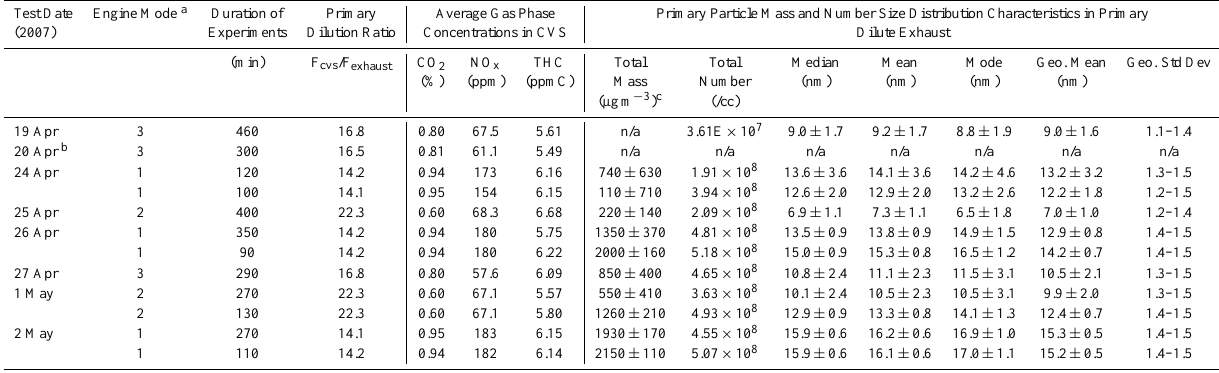
Fig. 1. An illustration of the experimental setup for this study. Section A shows the setup of the engine testing facility, where measurements of primary particles in the primary diluted exhaust in the CVS are made using SMPS, CPC, and filters. A small flow from the primary dilute exhaust in the CVS is pumped into the flow tubes, where it is mixed with laboratory generated seed particles. Arrows in Section B show the streams of air flow in the setup. Table 1. Engine Operating Conditions and Gas and Primary Particle Characteristics in the Constant Volume Sampler (CVS). Test Date Engine Mode a Duration